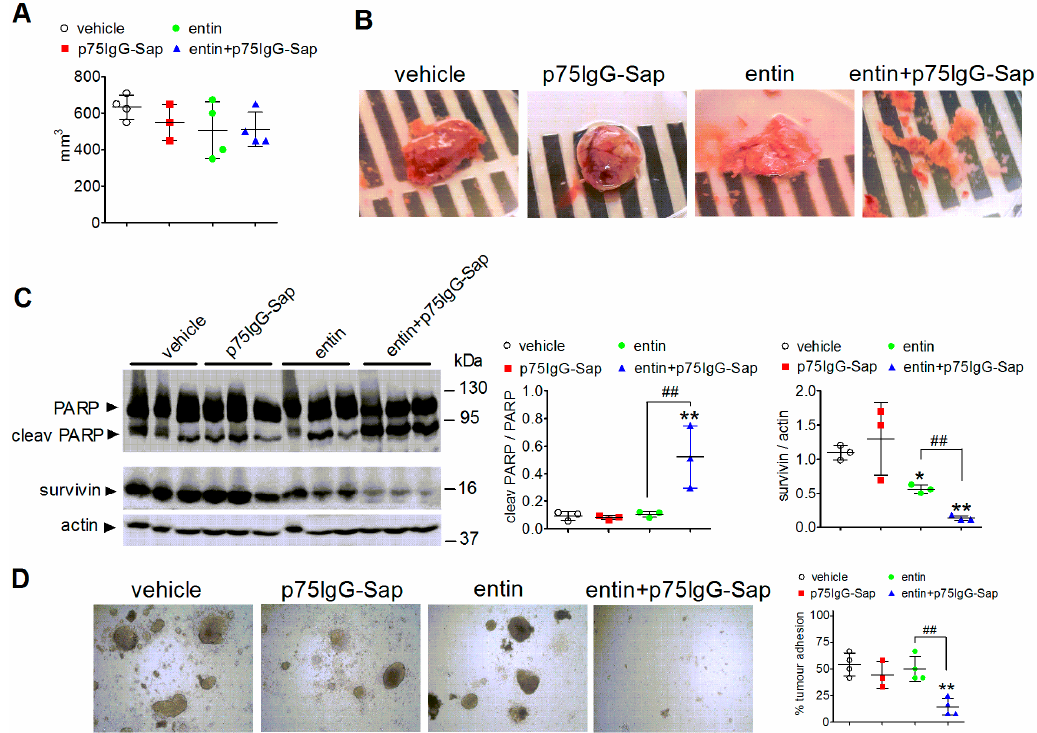
Figure 8. Cytotoxic effects of p75IgG-Sap in entinostat-treated neuroblastoma tumor xenografts. ( A ) Nude mice bearing xenografts of SH-SY5Y cells were treated for 10 days with either the vehicle or entinostat as indicated in Figure 7, and then injected twice with either the vehicle or p75IgG-Sap (5.0 µg) into two distal sites of the tumor. The scatter plot indicates the values (mean ± SD) of the tumor volumes that were measured 48 h after the last intratumoral injection. ( B ) Representative images of tumor xenografts that were acquired following resection from each experimental group. ( C ) Tumor xenografts of mice that were treated as indicated in ( A ) were analyzed for PARP cleavage and survivin expression by Western blot. Each lane was loaded with a sample that was obtained from an individual animal. Scatter plots indicate the absolute values of densitometric ratios and are the mean ± SD. ( D ) Tumor xenograft fragments were incubated for 96 h in complete growth medium. Thereafter, the medium was changed and the cell aggregates were analyzed by light microscopy to examine the growth and adhesion to the substrate. The scatter plot indicates the percent of tumor adhesion (mean ± SD) for each experimental group. * p < 0.05, ** p < 0.01 vs. vehicle; ## p < 0.01 by ANOVA followed by Tukey’s